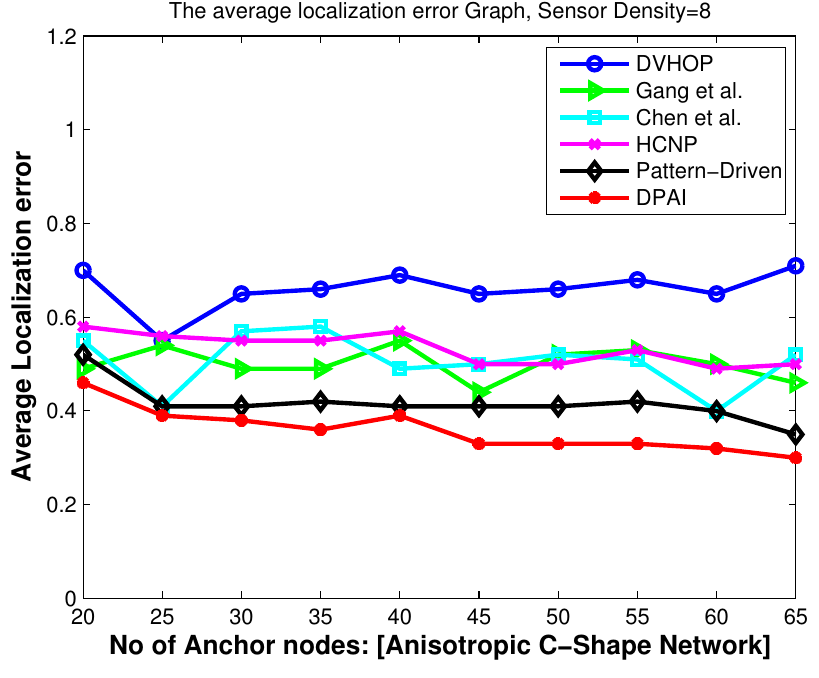
Figure 8. Location error vs . number of anchor nodes (C-shape network).